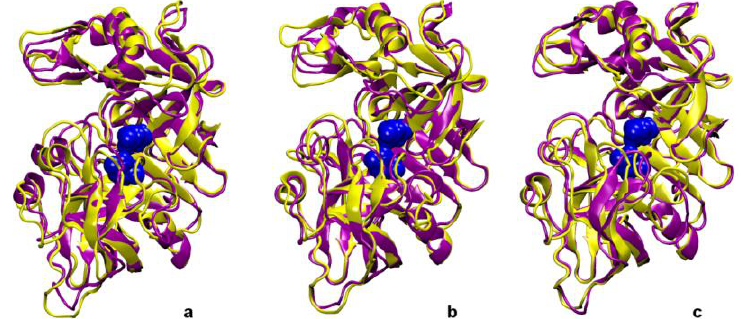
Figure 5. Superposition of the structure of pepsin at 0 ns (yellow) and at 20 ns (purple). Panel ( a ) simulation with the neutral channel. Panel ( b ) simulation with the charged channel. Panel ( c ) simulation with the charged channel and a lower number of water molecules.